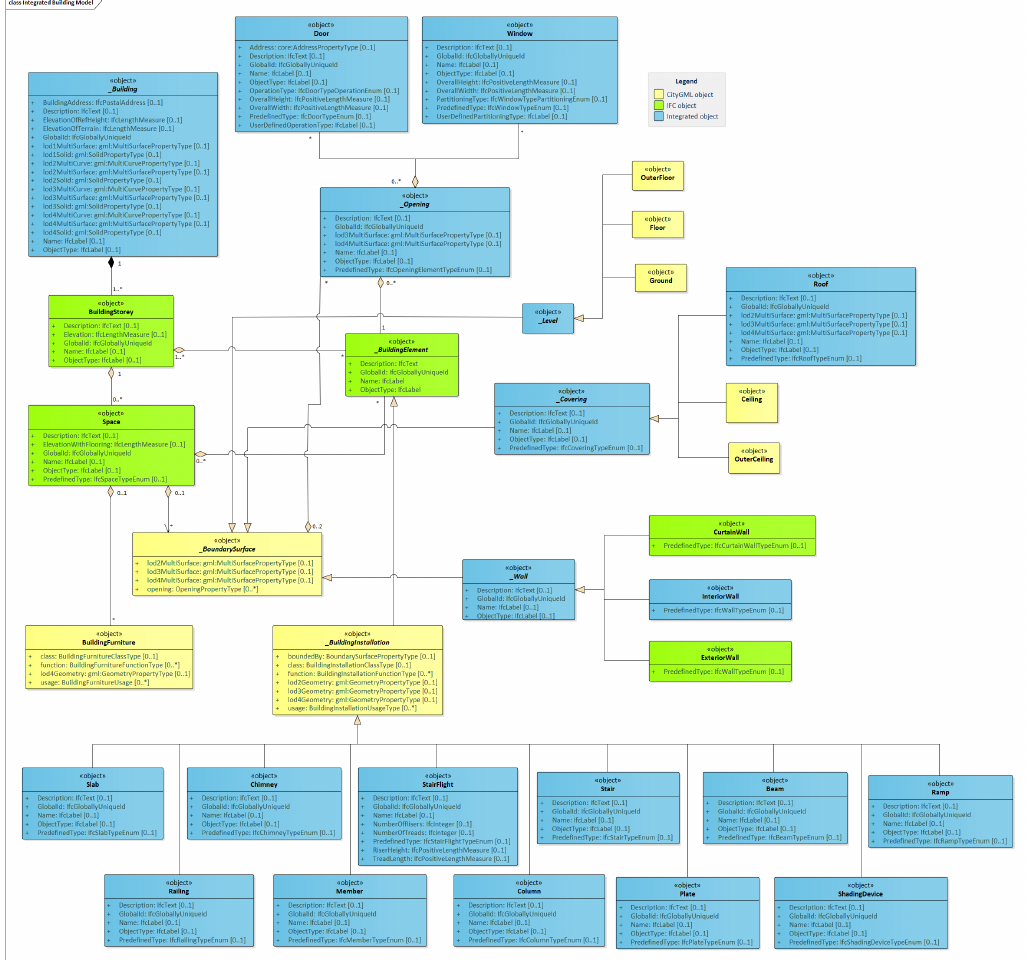
Figure 6. UML diagram of integrated building model